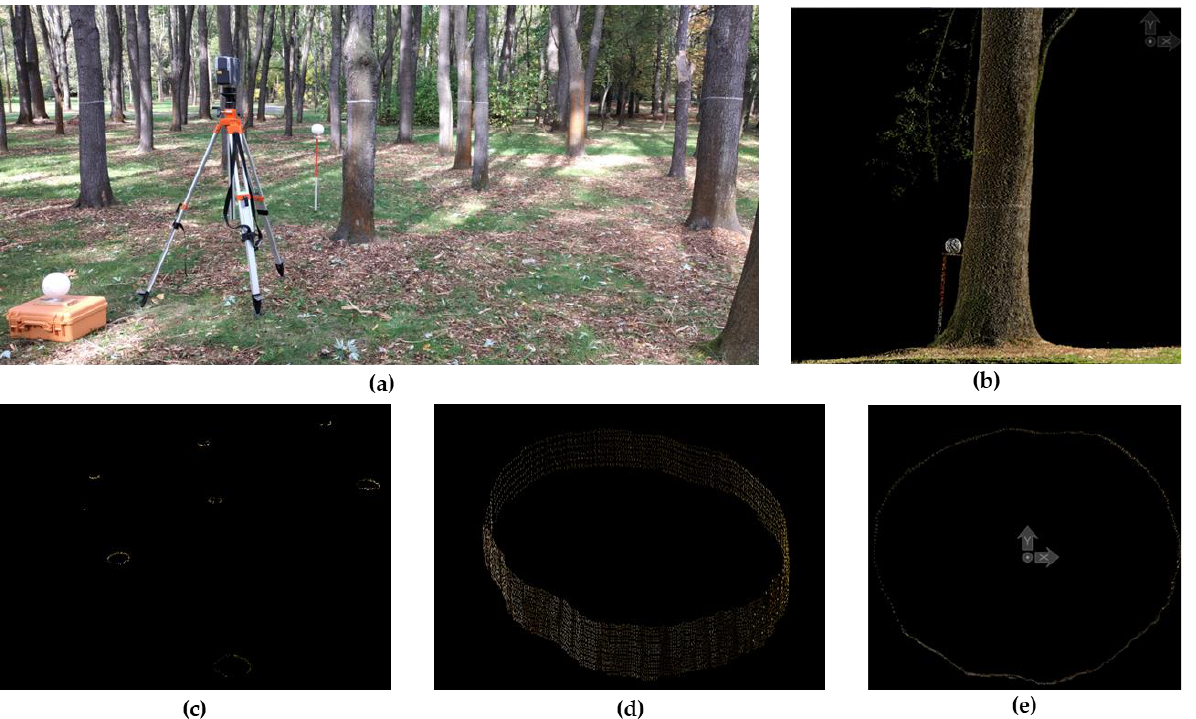
Figure 5. The FARO TLS scanning in a group of Acer saccharinum trees ( a ) showing in ( b ) the white mark at the PBH position on the trunk, part of the PBH slices of trees scanned ( c ), the thickness of the PBH slice from point clouds ( d ), and the slice of the PBH point cloud ( e ).